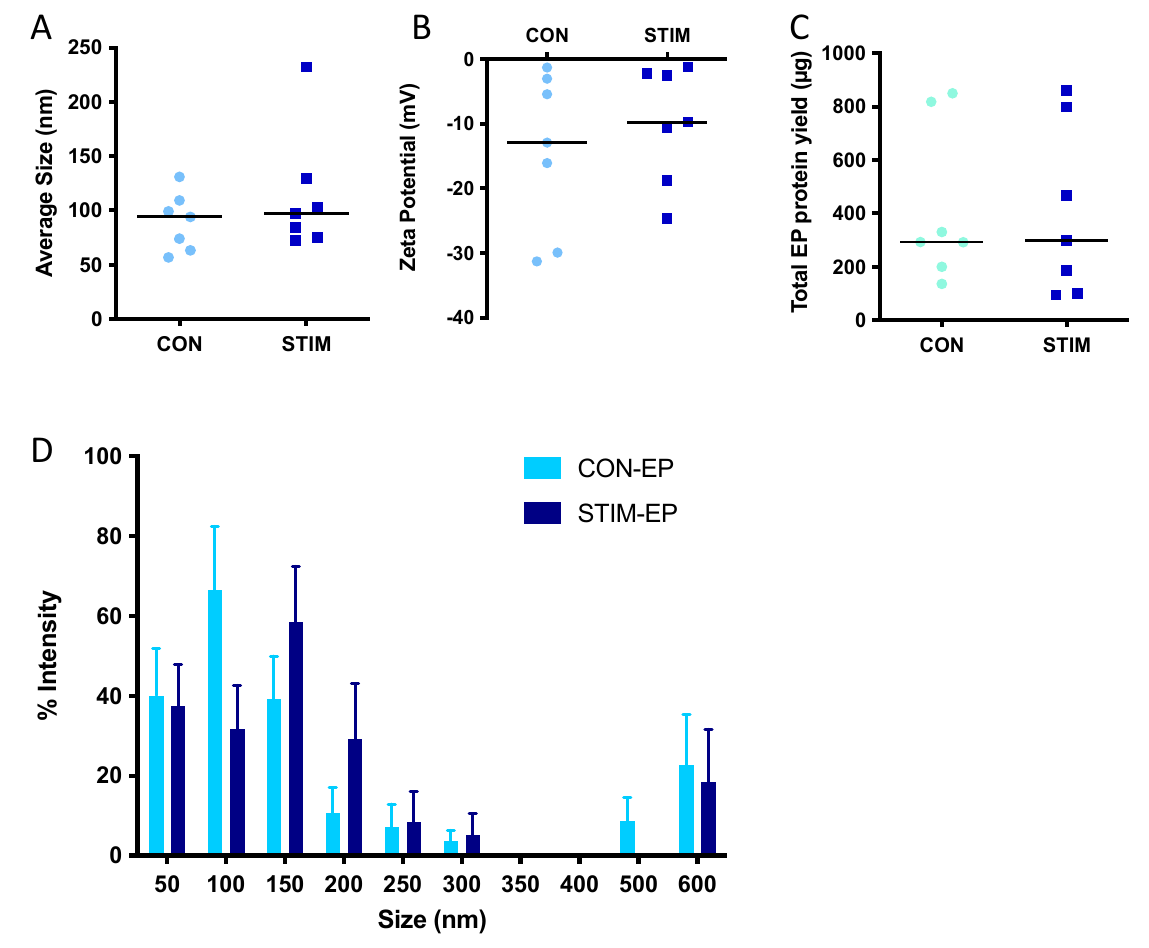
Figure 4. Effect of acute stimulation on EP size, zeta potential and protein yield. C2C12 myotubes were electrically contracted using an IonOptix EM-PACE for 1 h at 14 volts and EPs isolated from conditioned media. ( A ) Average size, ( B ) zeta potential and ( C ) protein yield remained unchanged between non-stimulated control (CON) and acutely stimulated (STIM) myotube-EPs ( n = 7). ( D ) No statistically significant differences in size distribution was found between CON-EPs and STIM-EPs ( n = 7). EPs were isolated using Total Exosome Isolation Reagent (ThermoFisher, Waltham, MA, USA). Data were analyzed using an unpaired Student’s t test, except for panel ( D ), which was analyzed by 2-way ANOVA. Data are expressed as scatter plots with means or bar graphs with mean ± standard error.